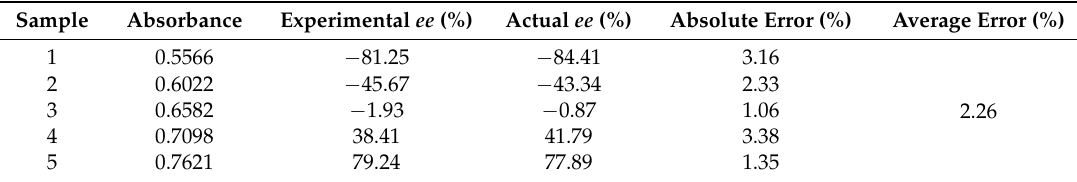
Table 1. Enantiomeric excess values of ( ± )-1,1 (cid:48) -bi-2-naphthol calculated from the SPE-based